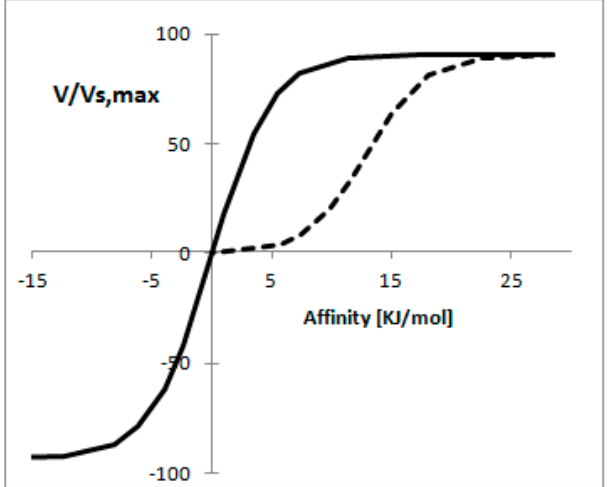
Figure 3. Forward reaction rate (v) of an enzyme-catalyzed reaction as a function of Affinity. The total concentration of substrate and product is assumed to be constant and equal to 10 mM. In solid line is represented a thermodynamic reversible reaction (v p = 100 [mmol/min mg], K p = K s = 1) and the dashed line represents a thermodynamically irreversible reaction (v p = 1, K p = 10 and K s = 1).